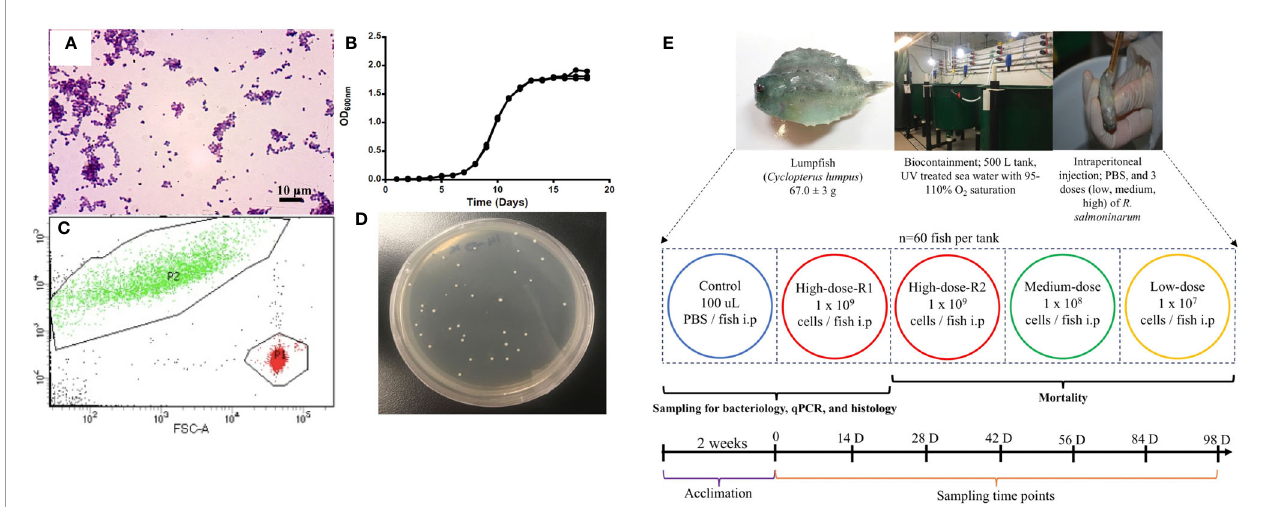
FIGURE 1 | Renibacterium salmoninarum infection in lump fi sh. (A) Characterization of R. salmoninarum by Gram staining; (B) R. salmoninarum growth curve in KDM2 broth; (C) Flow cytometric enumeration of R. salmoninarum . FSC: Forward Scatter; FITC: Green Fluorescence. In this plot of forward scatter versus fl uorescence, green signals in the upper left-hand frame represent bacteria stained with the SYTO BC bacterial stain; red signals in the lower right-hand frame represent microsphere particles, which serve as the standard used to indicate sample volume. P1: Number of signals in the microsphere frame; P2: Number of signals in the bacterial frame. (D) R. salmoninarum colonies growing on a SKDM2 spread plate inoculated for quantitative culture of the bacterium from fi sh head kidney; (E) Experimental design for this study. 300 lump fi sh (average weight: 67.0 ± 3 g) were divided in to 5 tanks (60 fi sh per tank) at the biocontainment facility. Fish from the control tank were intraperitoneally injected with 100 m l of PBS. Fish from the high (2 tanks for high dose; R1 and R2), medium, and low dose tanks were intraperitoneally injected with 100 m l of 10 9 , 10 8 , and 10 7 cells per fi sh of R. salmoninarum , respectively. The mock-infected tank (PBS control) and 3 experimental tanks [low, medium, and high (R2 tank) doses of R. salmoninarum ] were monitored for mortality. Fish for sampling of spleen, liver and head kidney were collected from the mock-infected tank and high dose R1 tank. Sampling time points were 0, 14, 28, 42, 56, 84, and 98 days post infection, and 6 fi sh were sampled at each time